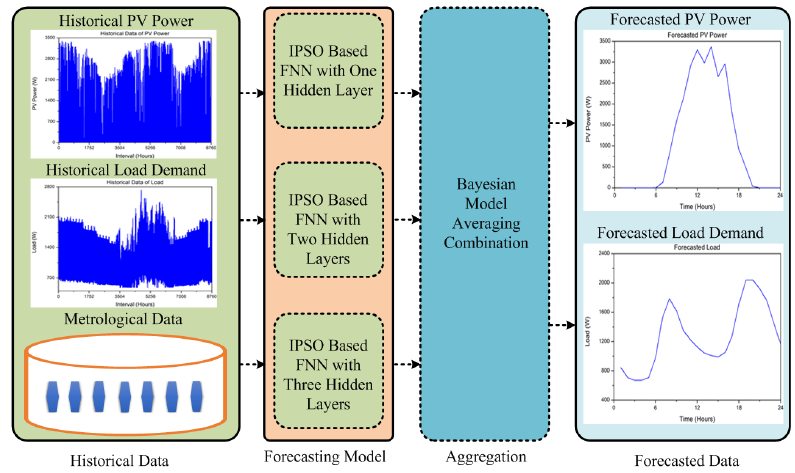
Figure 3. Proposed forecasting